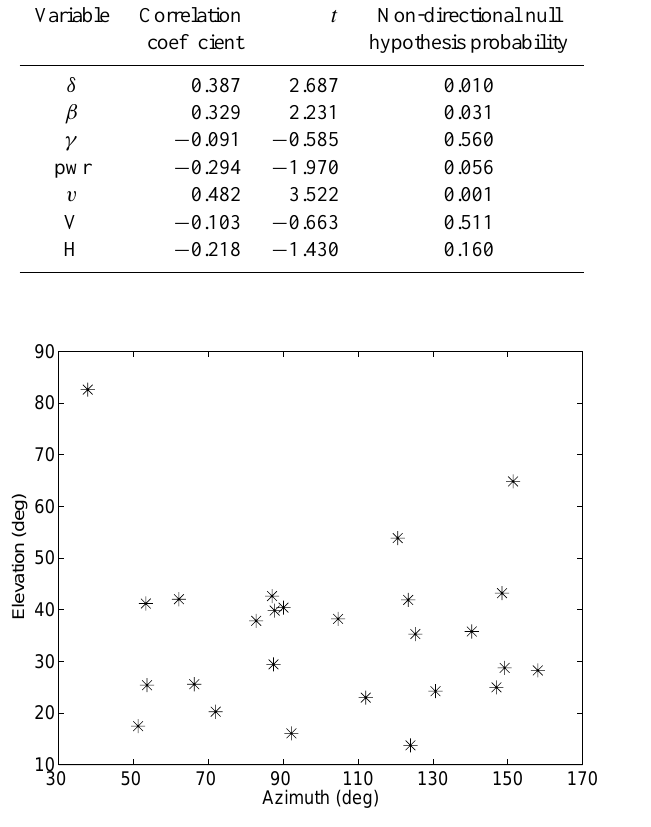
Fig. 6. Scatter plot showing the distribution of the points of origin of the observed events in azimuth-elevation space. 0 ◦ azimuth is due north, 90 ◦ is due east and 180 ◦ due south.